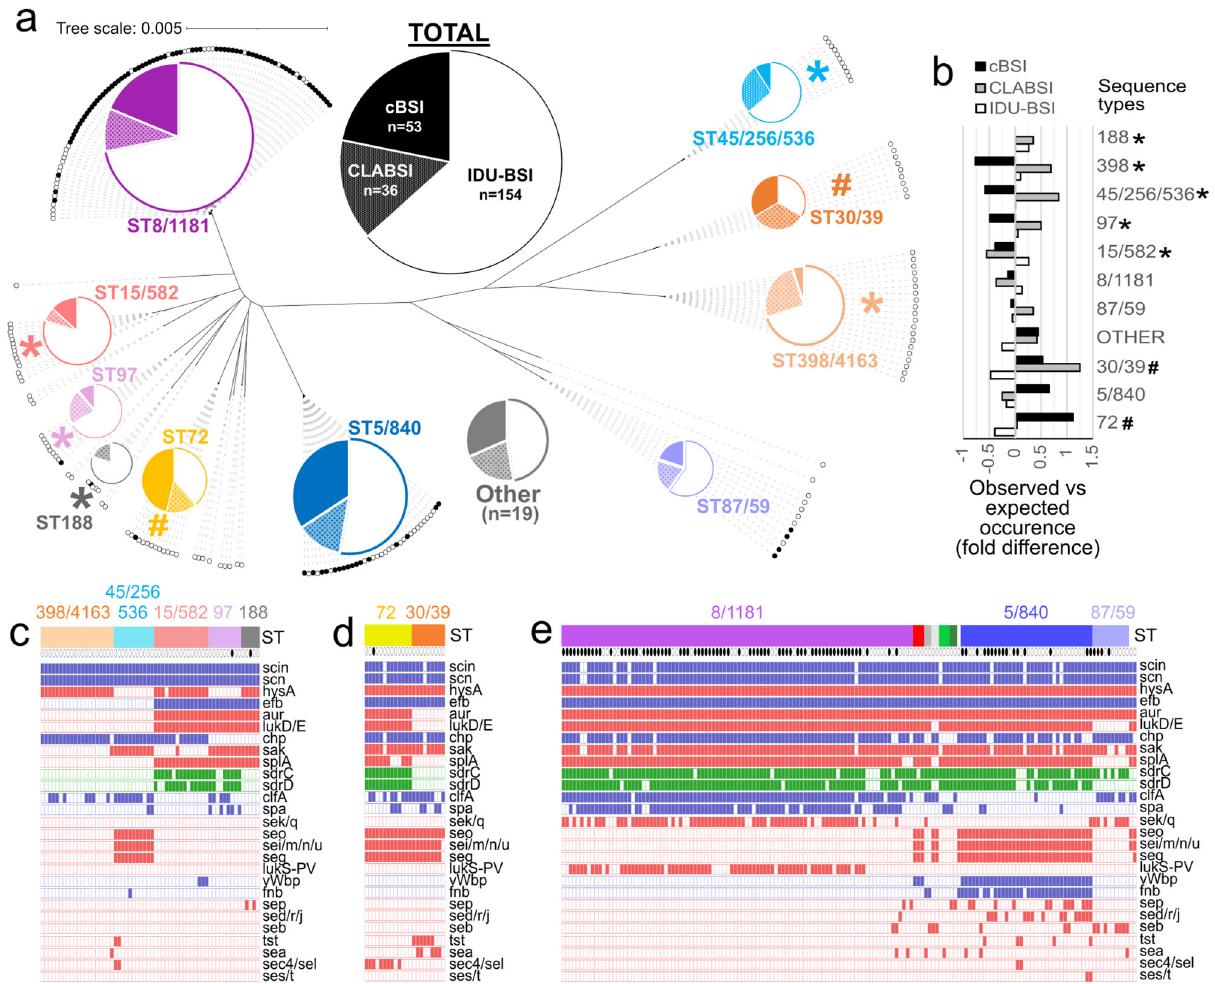
Fig. 5 Differential distribution of phylogenetic subgroups and canonical virulence factor genes among different BSI types. a Unrooted version of the maximum-likelihood phylogenetic tree shown in Fig. 1, with each MRSA or MSSA isolate represented by a fi lled or empty circle, respectively. Pie charts represent the portion of each ST subgroup that was obtained for cBSI (solid), CLABSI (stippled) or IDU-BSI (white) cases. Only subgroups with ≥ 5 isolates are represented in pie charts. All other isolates ( n = 19) were grouped as “ Other ” . b Fold differences of the observed versus expected incidence of each ST subgroup among cBSI (black bars), CLABSI (gray bars) and IDU-BSI (white bars) isolates in our cohort. No ST188 strains were identi fi ed among cBSI isolates. In panels a and b , (*) and (#) denote ST groups whose incidence was <75% of expected among cBSI and IDU-BSI isolates, respectively. c – e Representation of the genome content of ST subgroups underrepresented in cBSI (panel c ), subgroups underrepresented in IDU-BSI (panel d ) and all other subgroups (panel e ). Each column represents a genome. First row denotes ST subgroup, with the genomes grouped as “ Other ” are lacking labels. Second row denotes MRSA ( fi lled) or MSSA (empty) isolates. Subsequent rows show the presence ( fi lled square) of canonical virulence factor genes, which are subclassi fi ed according to their roles in either immune evasion (blue), toxin production (red), or bio fi lm formation (green). Source data for this fi gure is derived from analysis of genome sequences uploaded at NCBI under BioProjects PRJNA694991 and PRJNA695316 and is available in tabular form in Supplementary Data